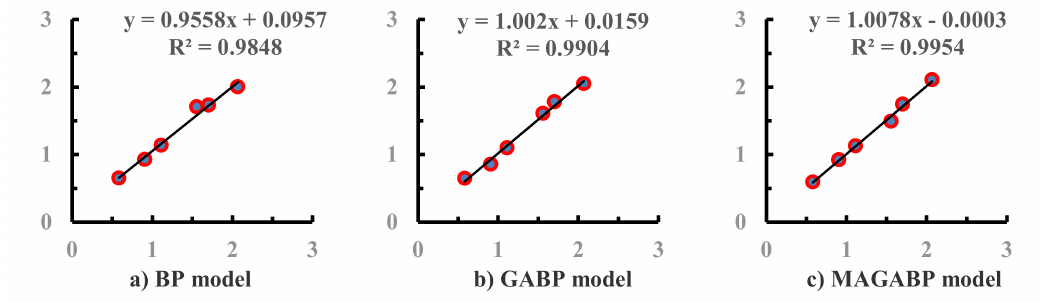
Figure 11. Comparison of the coe ffi cient of determination R 2 of di ff erent